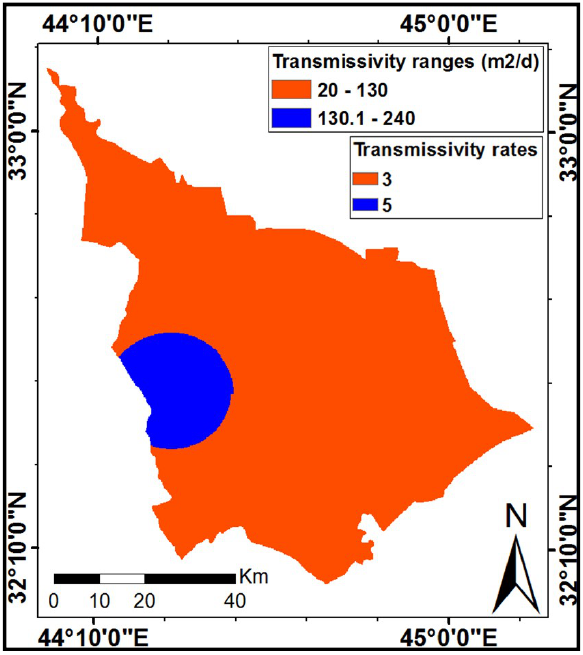
Figure 7. Transmissivity maps (ranges and Figure 7 . Transmissivity maps (ranges and rates).